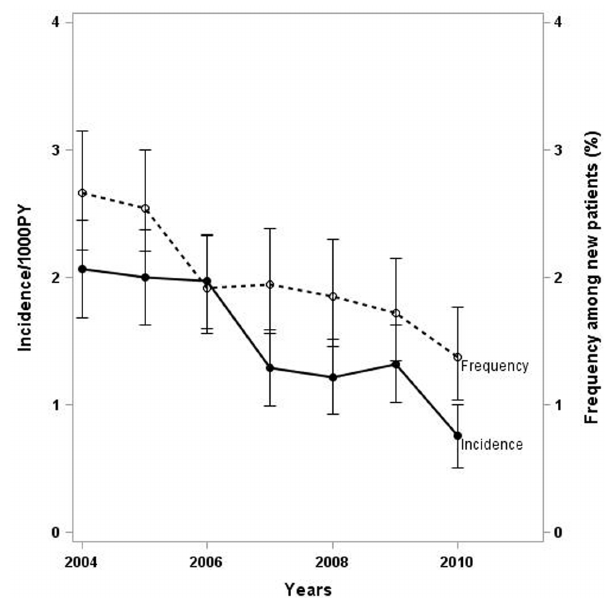
Figure 1. Trends in the risk of PCP overtime: incidence of first PCP for previously enrolled patients (bolt line) and frequency of inaugural PCP in newly enrolled patients (dotted line).